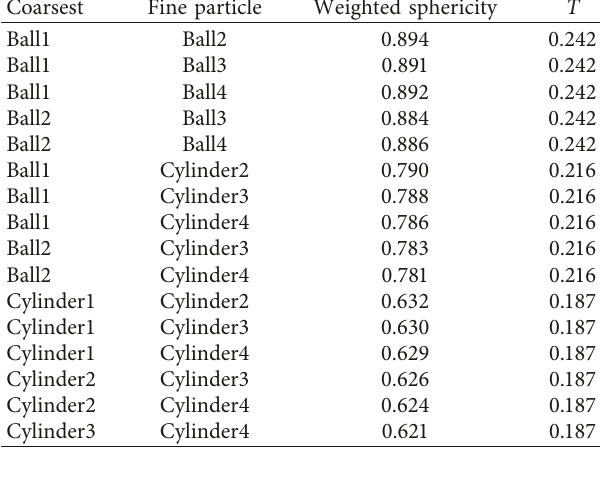
Table 7: The weighted sphericity versus the minimum value of the minimum void ratio for the alternative material mixture. Coarsest